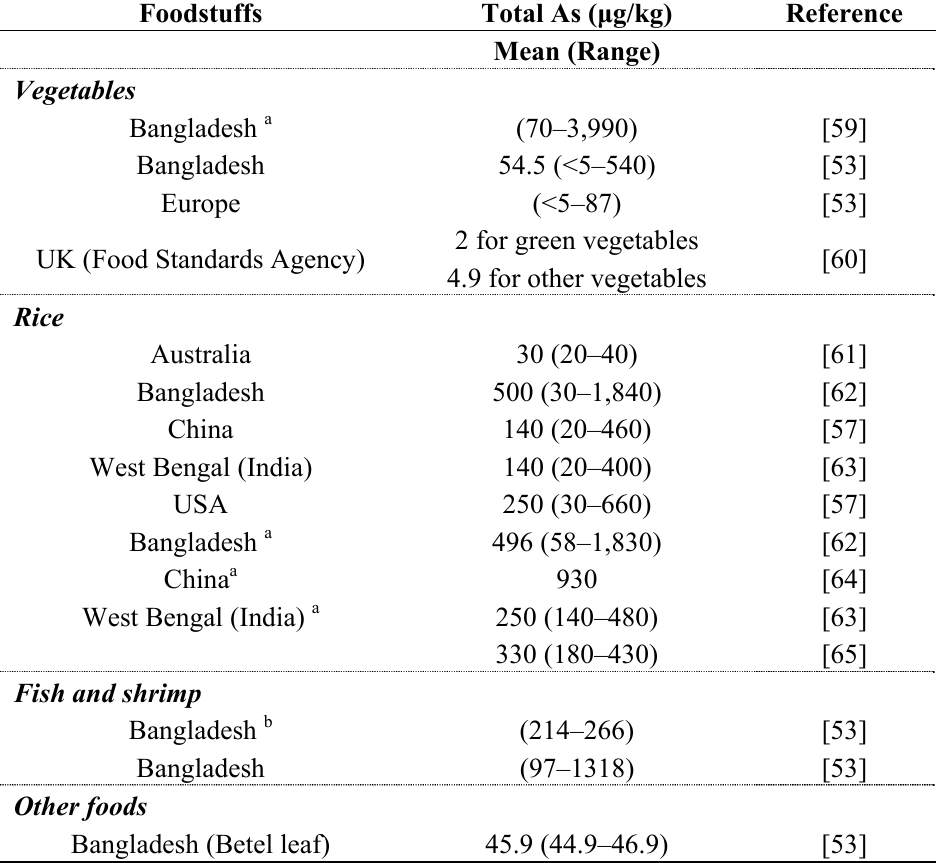
Table 3. Arsenic contents ( μ g/kg) in food composites from different